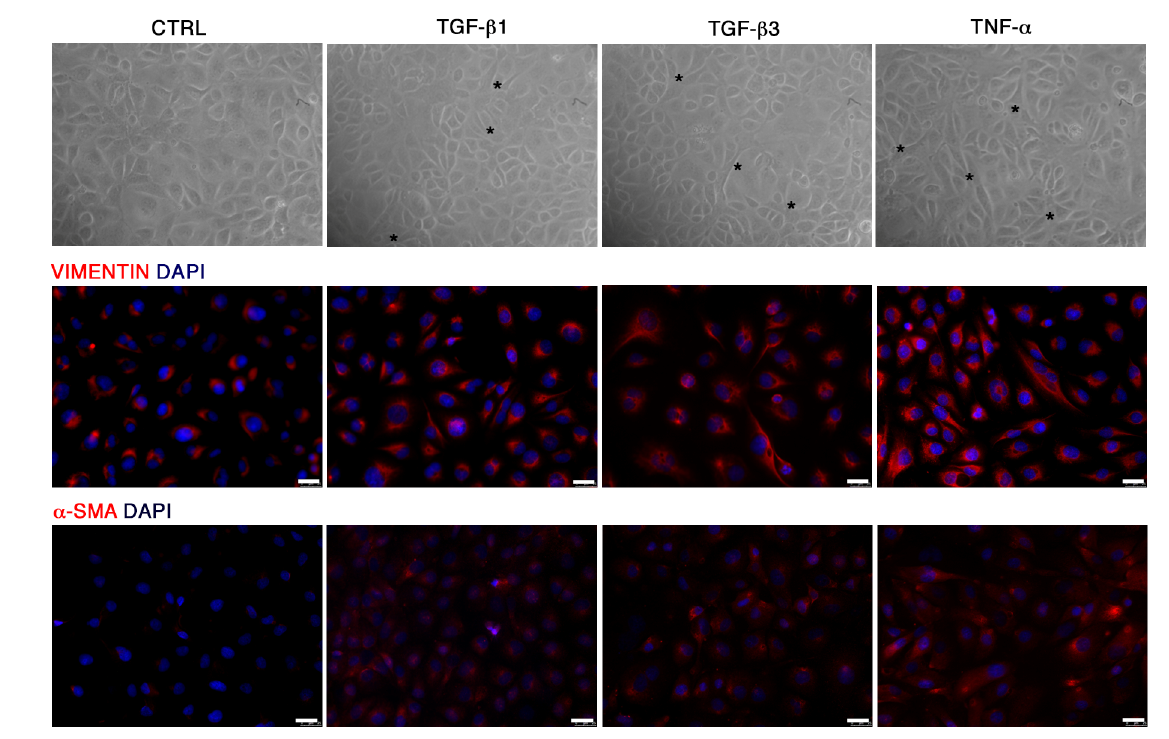
Figure 3. Progression of the End–MT at 6 days. ( A ) Morphological variations occurring in HUVECs after 6 days exposure to TGF- β 1, TGF- β 3 and TNF- α , observed under the light microscope (20 × magnification). Analysis of ( B ) VIMENTIN and ( C ) α -SMA protein expression by immunofluorescence in HUVECs highlighted the gain of mesenchymal phenotype and the loss of the typical endothelial cobblestone morphology (Scale bars = 25 µ m). All figures are representative of 3 independent experiments. α -SMA, smooth muscle actin.